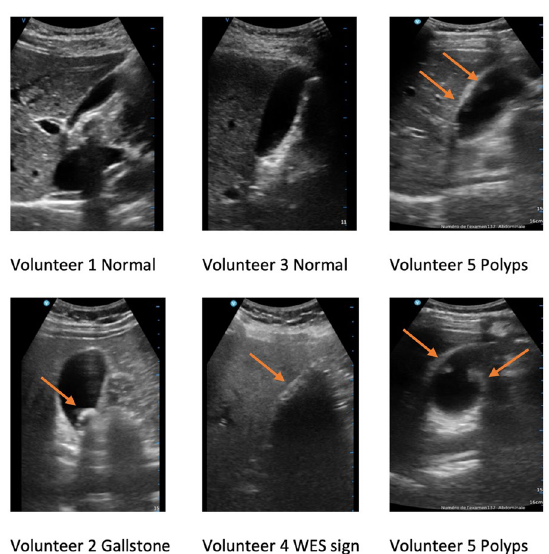
Fig. 2 Gallbladder ultrasound images from the evaluation day. WES: